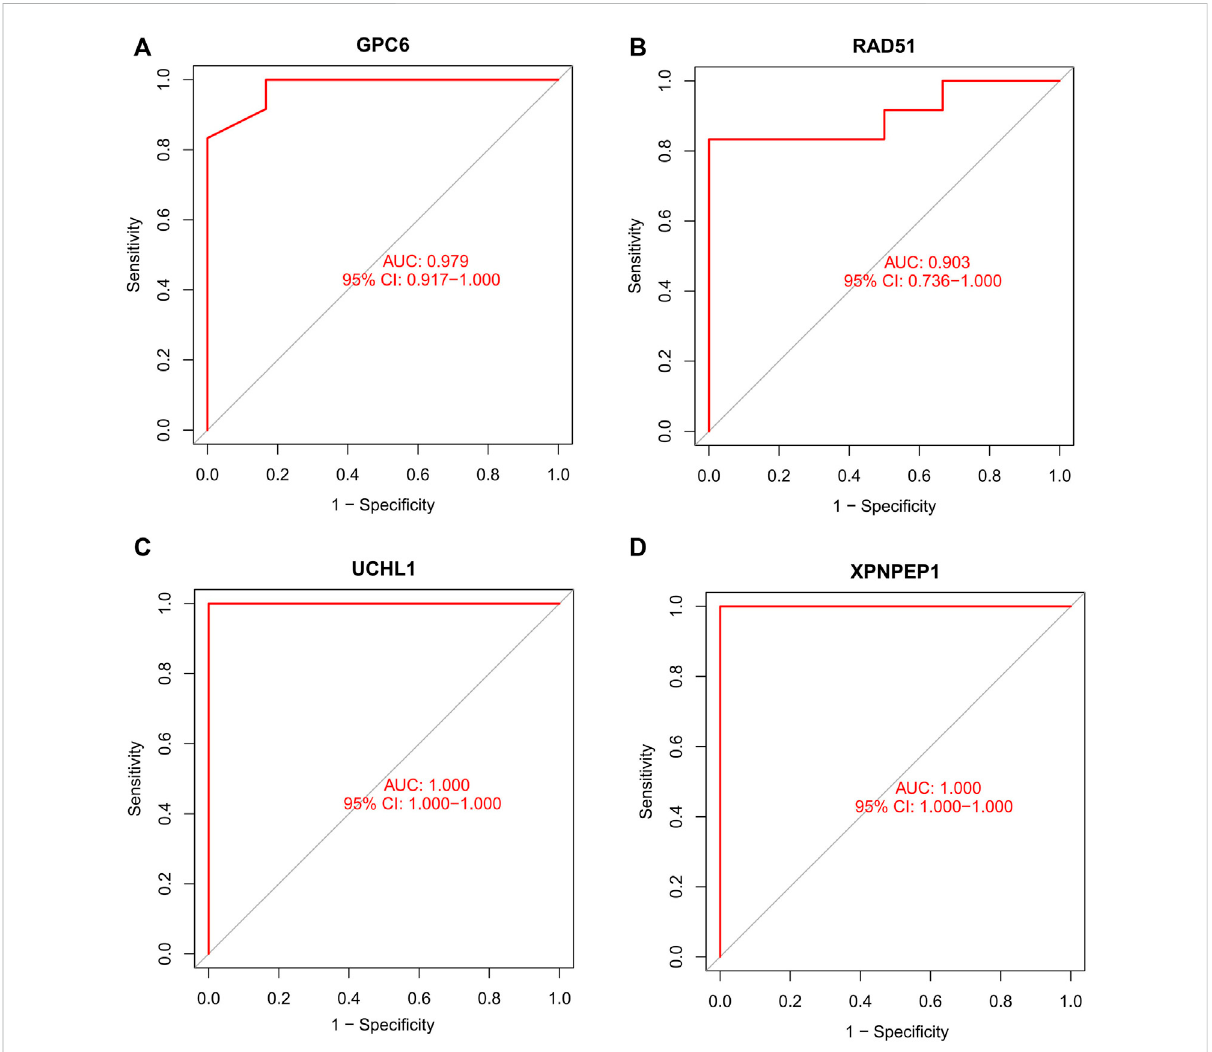
FIGURE 9 Receiver operating characteristic (ROC) curve of differentially gene ’ s ability to exclude ACS diagnosis in the GSE95368 dataset.